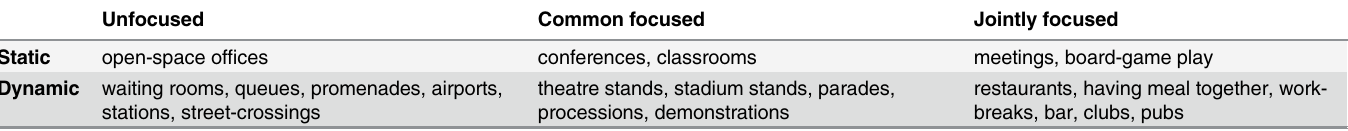
Table 1. Gatherings categorisation on the basis of focus of attention and spatio-proxemic freedom exemplified by typical social settings/ situations. Unfocused